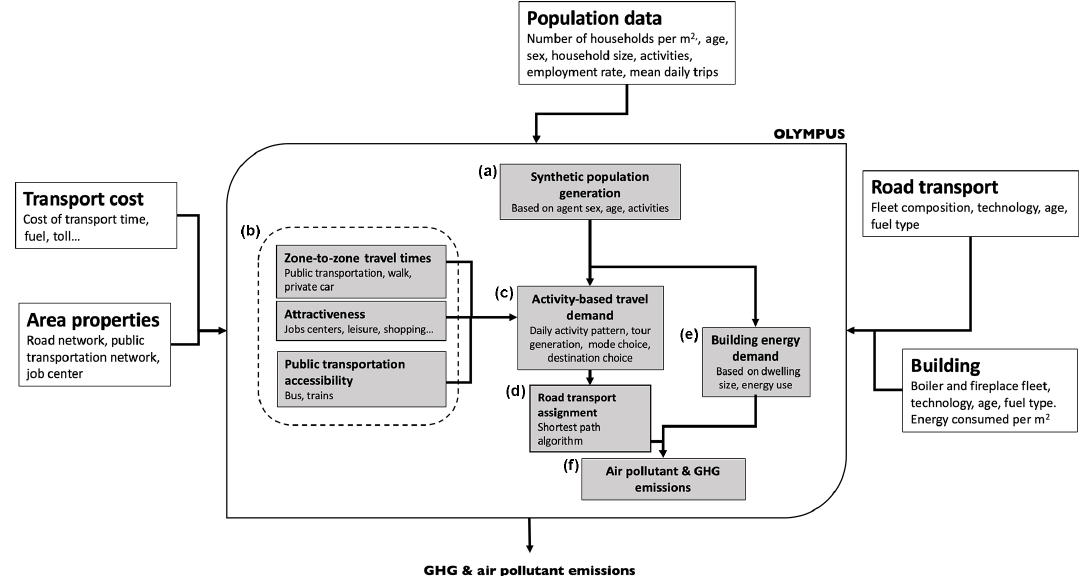
Figure 1. Flowchart showing the OLYMPUS emissions operating system, as well as its main modules. (a) The synthetic population genera- tion module (GAIA). (b) The generator of the transport time matrix, transportation accessibility indices and attractiveness of areas (THEMIS). (c) The transport demand module based on the activity of the synthetic population, and the modal choice in terms of transport (MOIRAI). (d) The module for assigning the travel demand on the road network (HERMES). (e) The module for the generation of energy demand at the regional level. (f) The module for the calculation of greenhouse gas and air pollutant emissions based on emission factors.